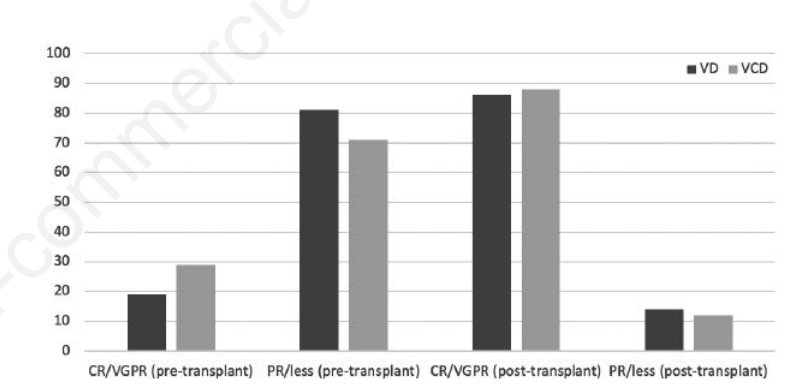
Figure 1. Pre-transplant and post-transplant response rates for VD and VCD regimens.